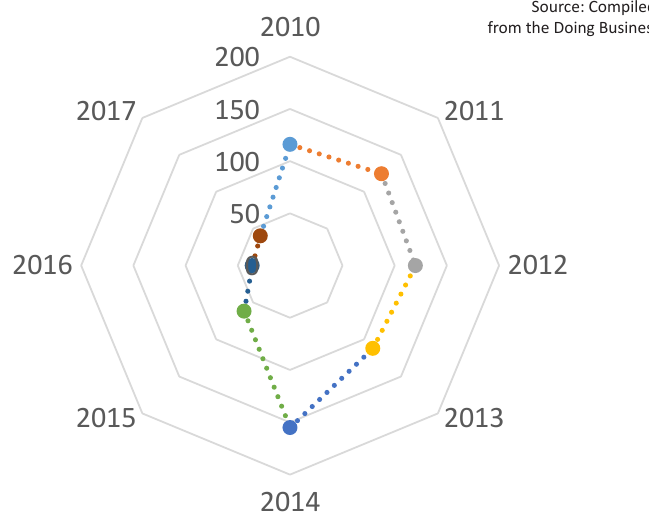
Figure 1. Rating indicators of Russia in the Doing Business Report in